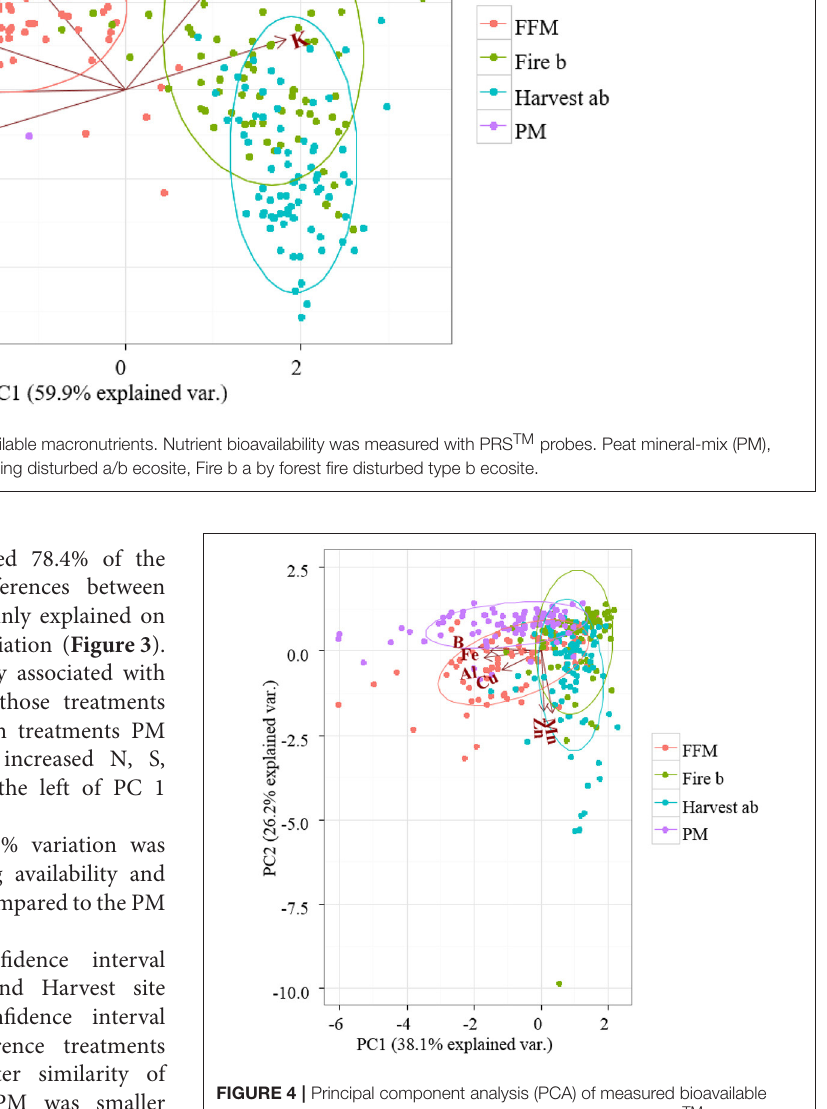
increased B, Fe, Al, and Cu availability. A downward shift of FFM, Harvest, and the Fire site on the axis of PC2 were associated with increased Mn and Zn availability ( Figure 4